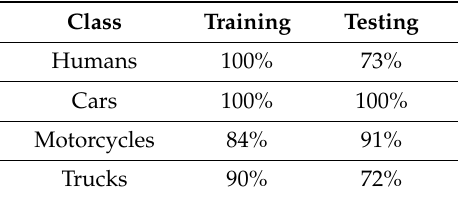
Table 10. Default LLM forecast training and testing prediction accuracy.